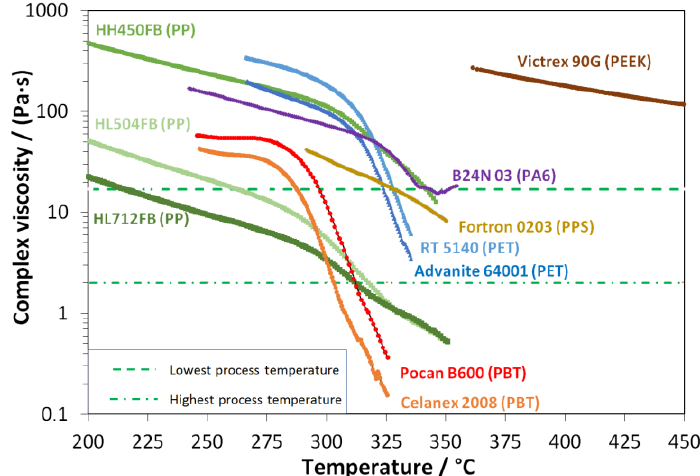
Figure 4. Process temperature windows of different polymer types for the Nanoval process, defined by the shear rheological temperature sweeps (ω = 10 rad ꞏ s −1 , ε = 10%, 𝑇̇ = 0.5 K ꞏ min −1 ) and observed onset temperatures of process limitations (dotted line: min. process temperature; dot-line-dot: max. process temperature); the related plots of the storage- and loss modulus are given in the supplementary materials (see Supplementary Materials Figure S3 ) .